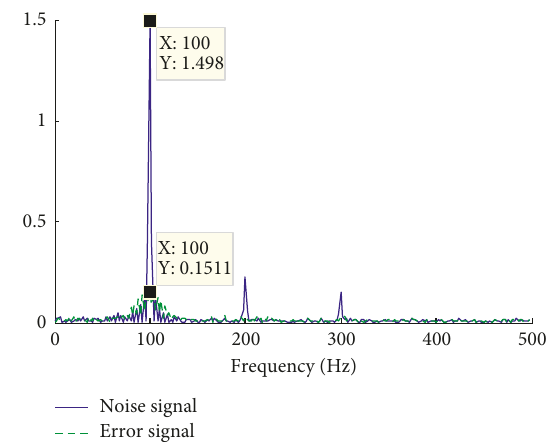
Figure 8: Amplitude-frequency curves of noise and error signals. Table 1: The gear ratio in each gear.